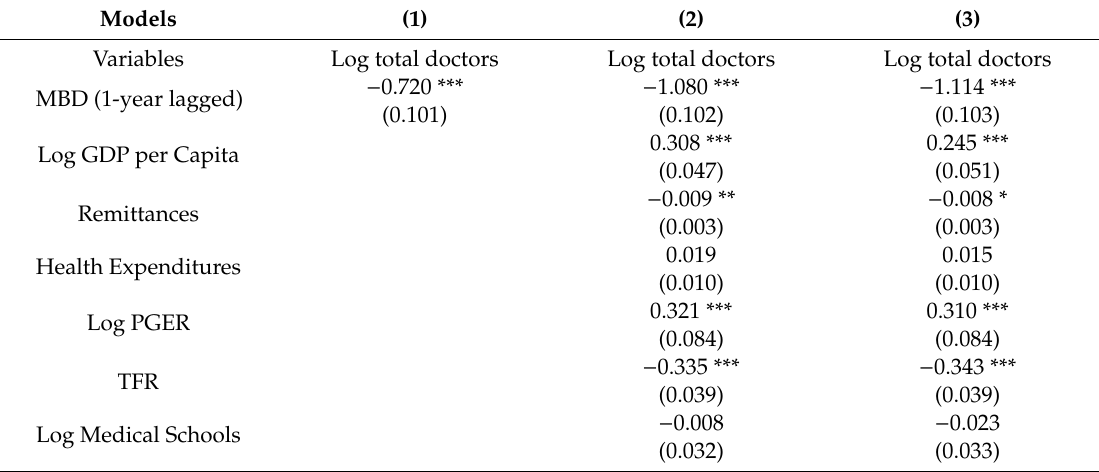
Table 2. Fixed-effects regression of MBD (1-year lagged) on total number of doctors (logged) in 188 countries over 2000–2015.